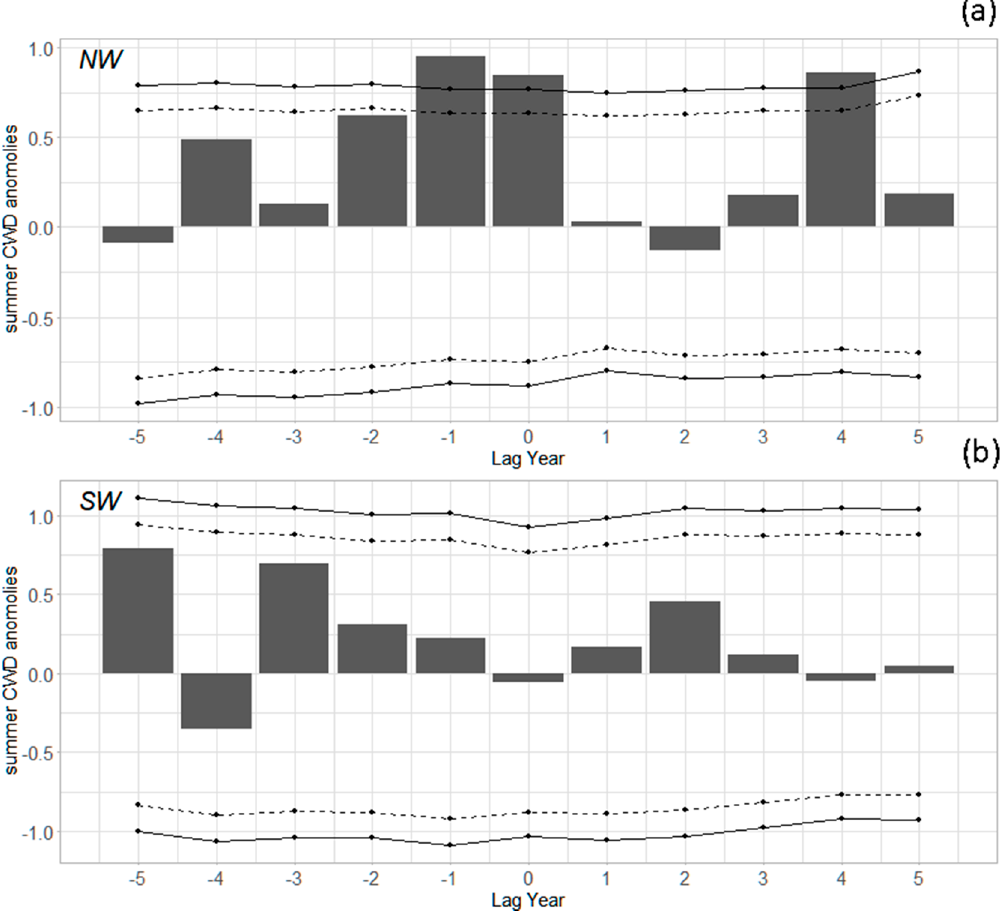
Figure 6. Superposed epoch analysis of summer standardized anomalies of climatic water deficit (CWD). ( a ) Mean of regions in the Northwest ( N = 5); ( b ) mean of regions in the Southwest ( N = 3). Dotted lines indicate 90% confidence intervals, and solid lines indicate 95% confidence intervals. Values outside these intervals are years when the climate was statistically significantly different from average conditions. For example, “Lag 0” is the year of outbreak initiation, and “Lag − 1” is the year before initiation.